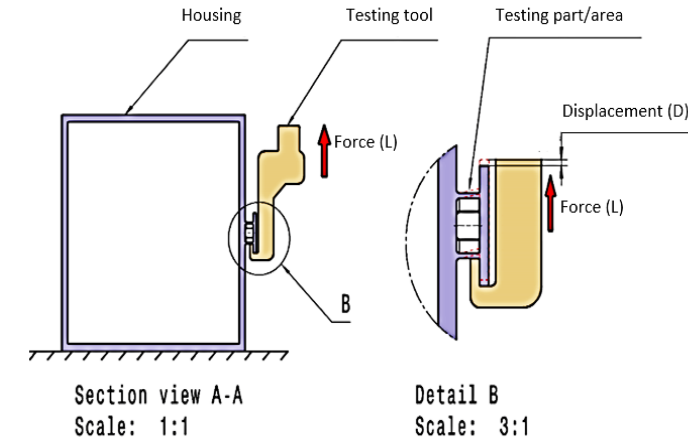
Figure 2. Loading scheme of housing parts.